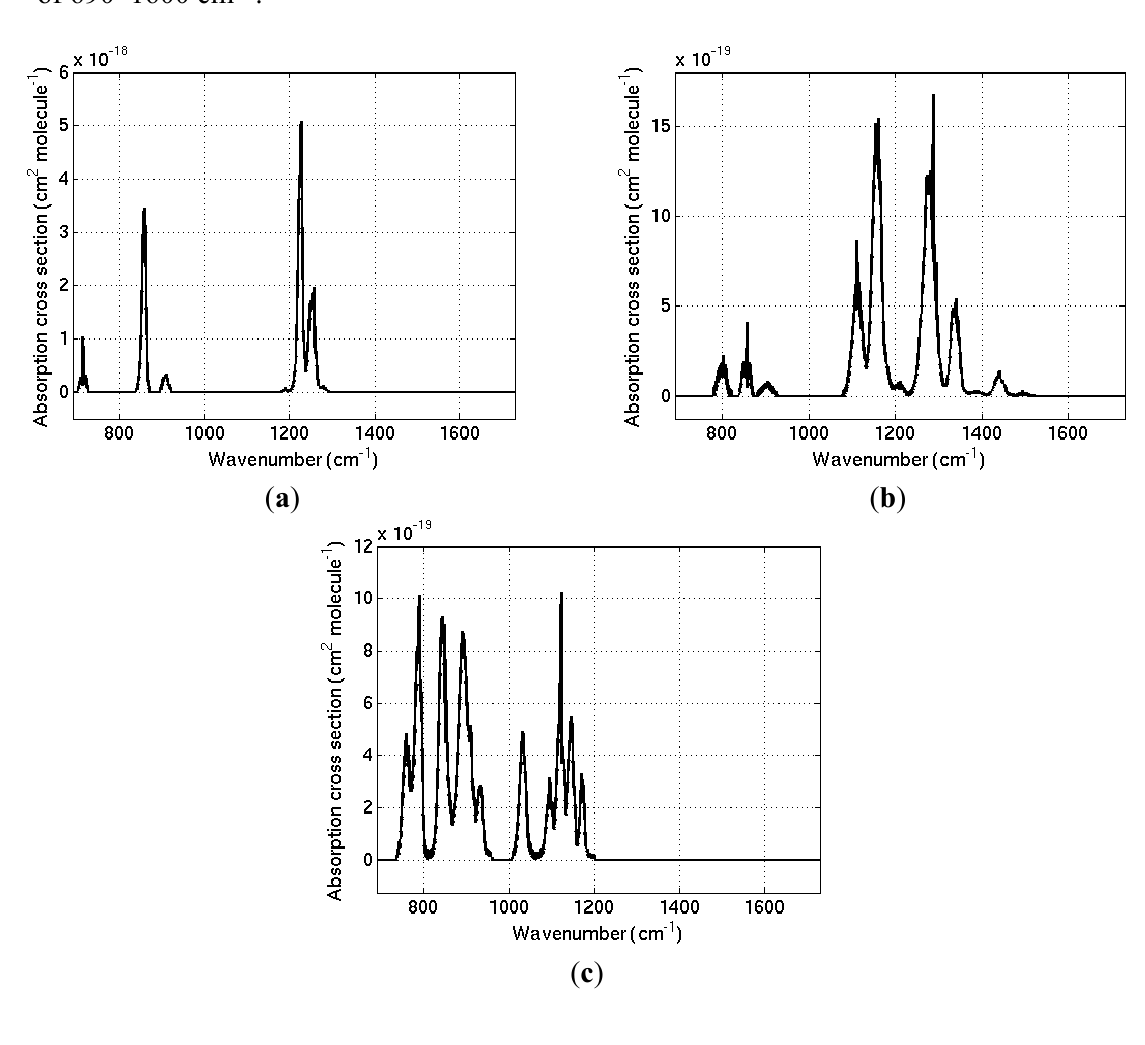
Figure 2. Absorption spectrum at 295 K for: ( a ) 2.7 Torr of CFC-113a; ( b ) 6.96 Torr of HCFC-133a; and ( c ) 8.1 Torr of a 90.8%/9.2% mixture of CFC-112/112a within the range of 690–1600 cm − 1